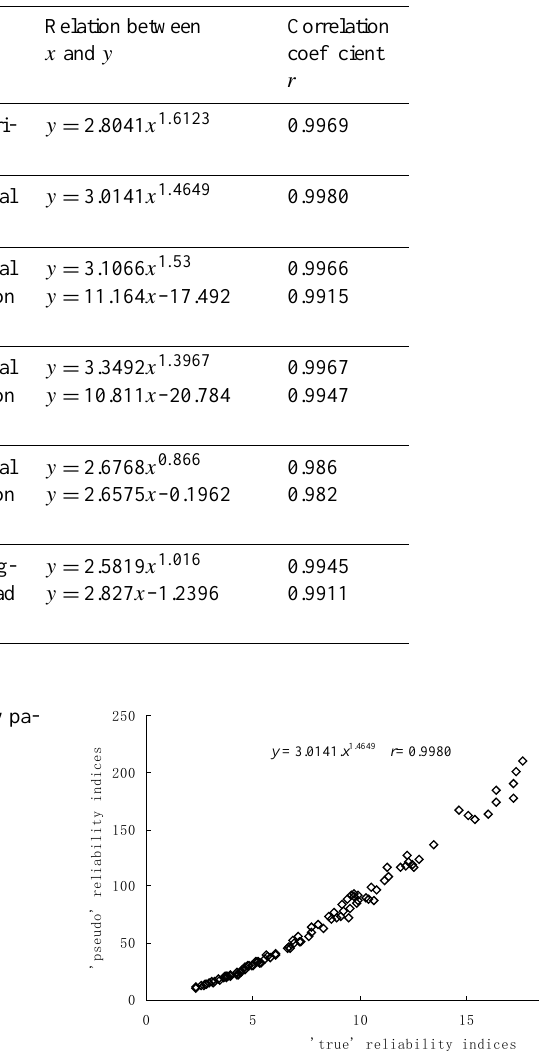
Figure 7. Relations between pseudo reliability indices and true re- liability indices of 100 trial circular slip surfaces (log-normal distri- bution + Bishop